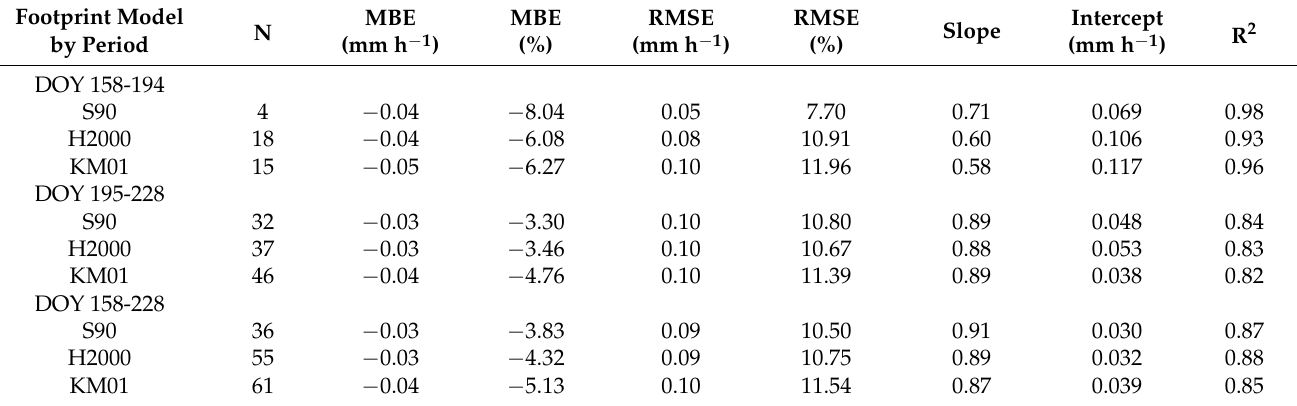
the KM01. Table 4. Comparison of the composite ET calculated using a combination of the lysimeter and EC data to the ET from EC8 for the different growth stages and the entire study period. Footprint Model by Period